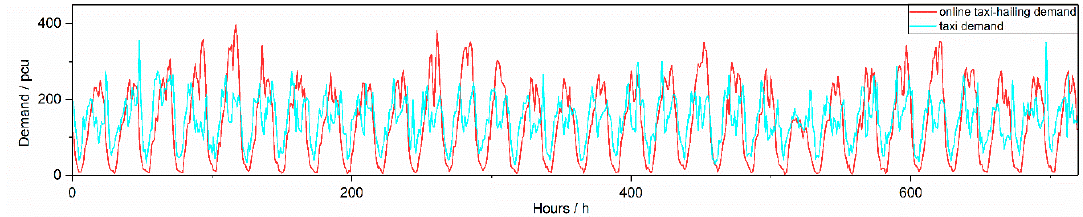
Figure 4. The demand for taxi and online taxi-hailing in Bell Tower area. Table 6. Predictive indicators of trip demand.